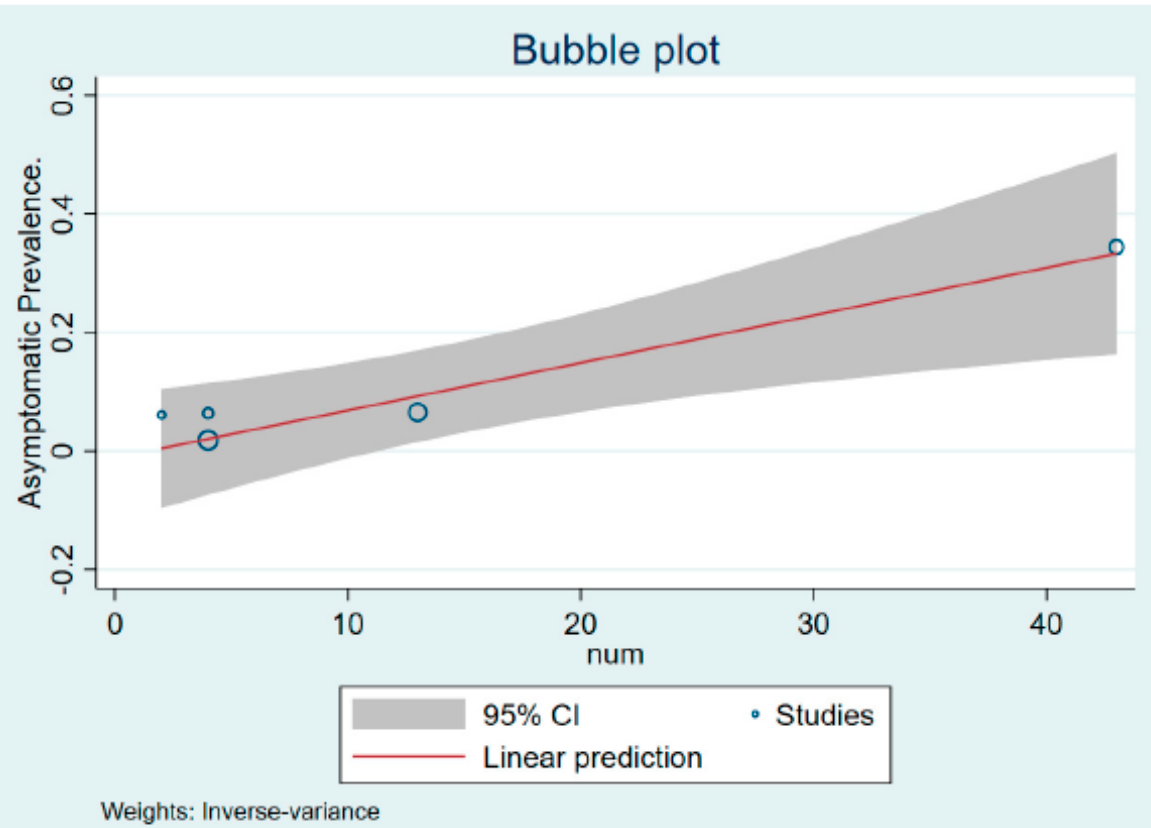
Figure 3. Bubble plot based on the percentage of asymptomatic monkeypox cases. Result Synthesis